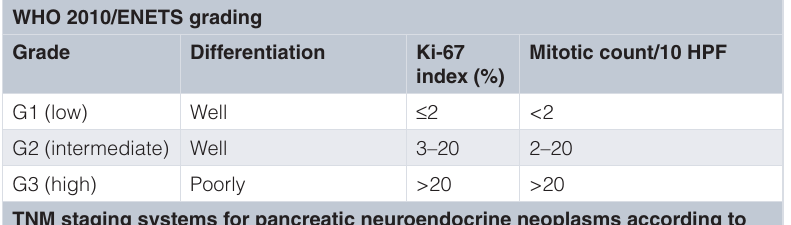
Table 2. Pancreatic neuroendocrine tumors: WHO classification and TNM